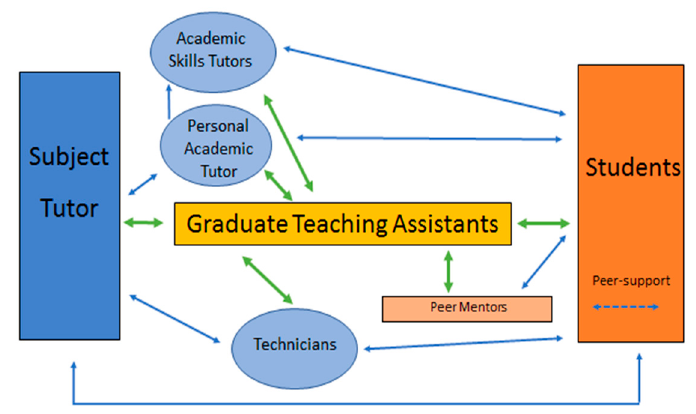
Figure 3. Student support and communication channels in the case study.